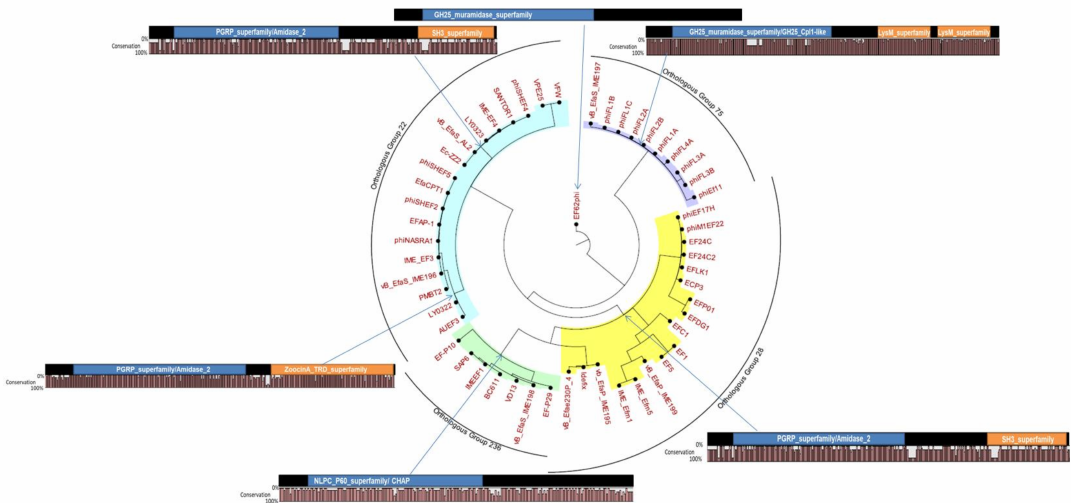
Figure 3. Maximum likelihood phylogenetic analysis sequence relatedness of E. faecalis phage endolysin functional domains; tree node labels represent the bootstrap values; the sequence similarity between functional domains is evidenced by using identical filling patterns; in blue—active domain; in orange—biding in domain; each of the four orthologous group is represented by a di ff erent color; Ef62phi could not be associated to any orthologous